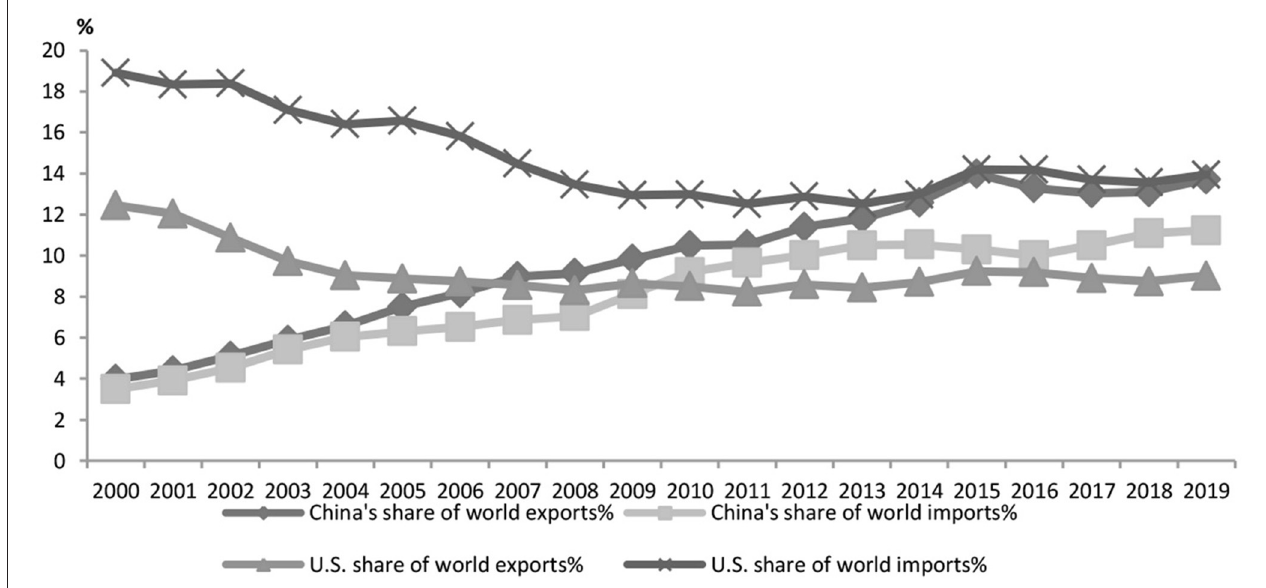
FIGURE 1 | Changes in China and the United States’ share of global imports and exports. Data source: UN Comtrade Database.